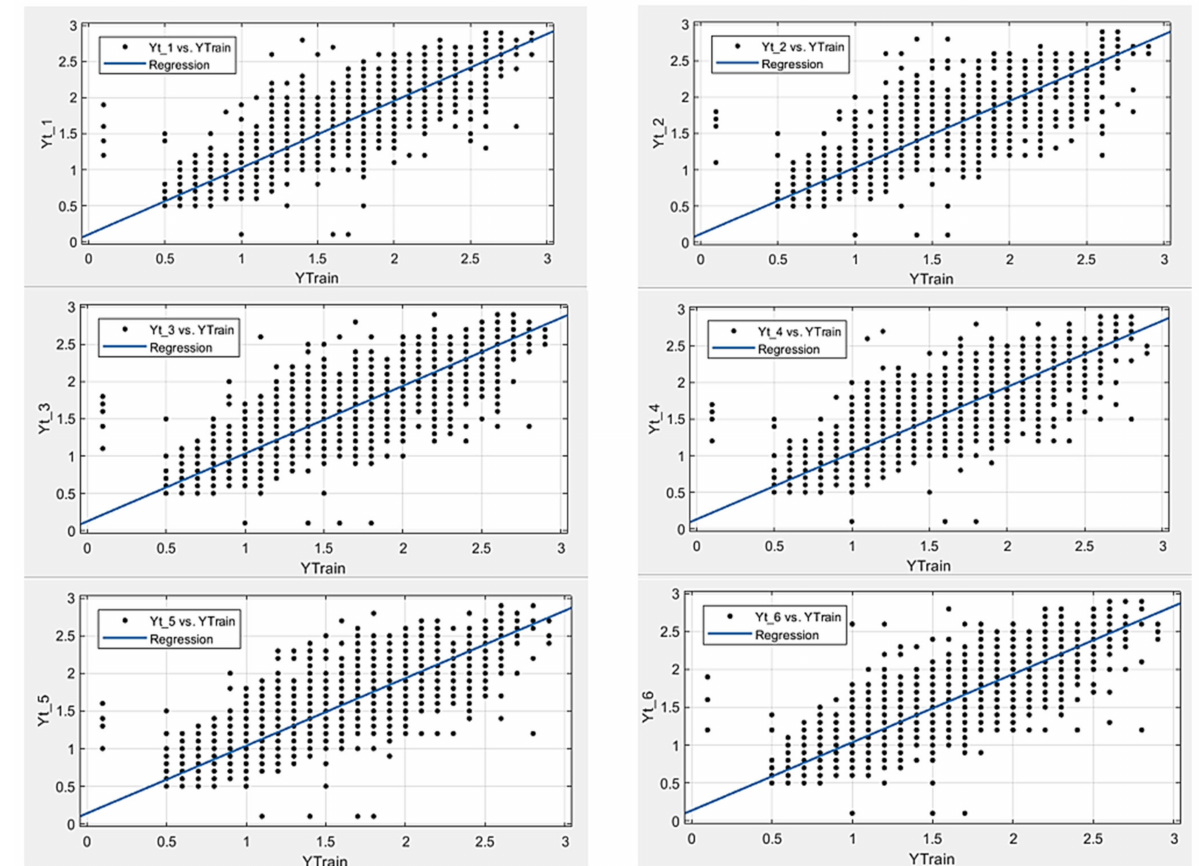
Figure 6. Correlation with the previous six load lags.